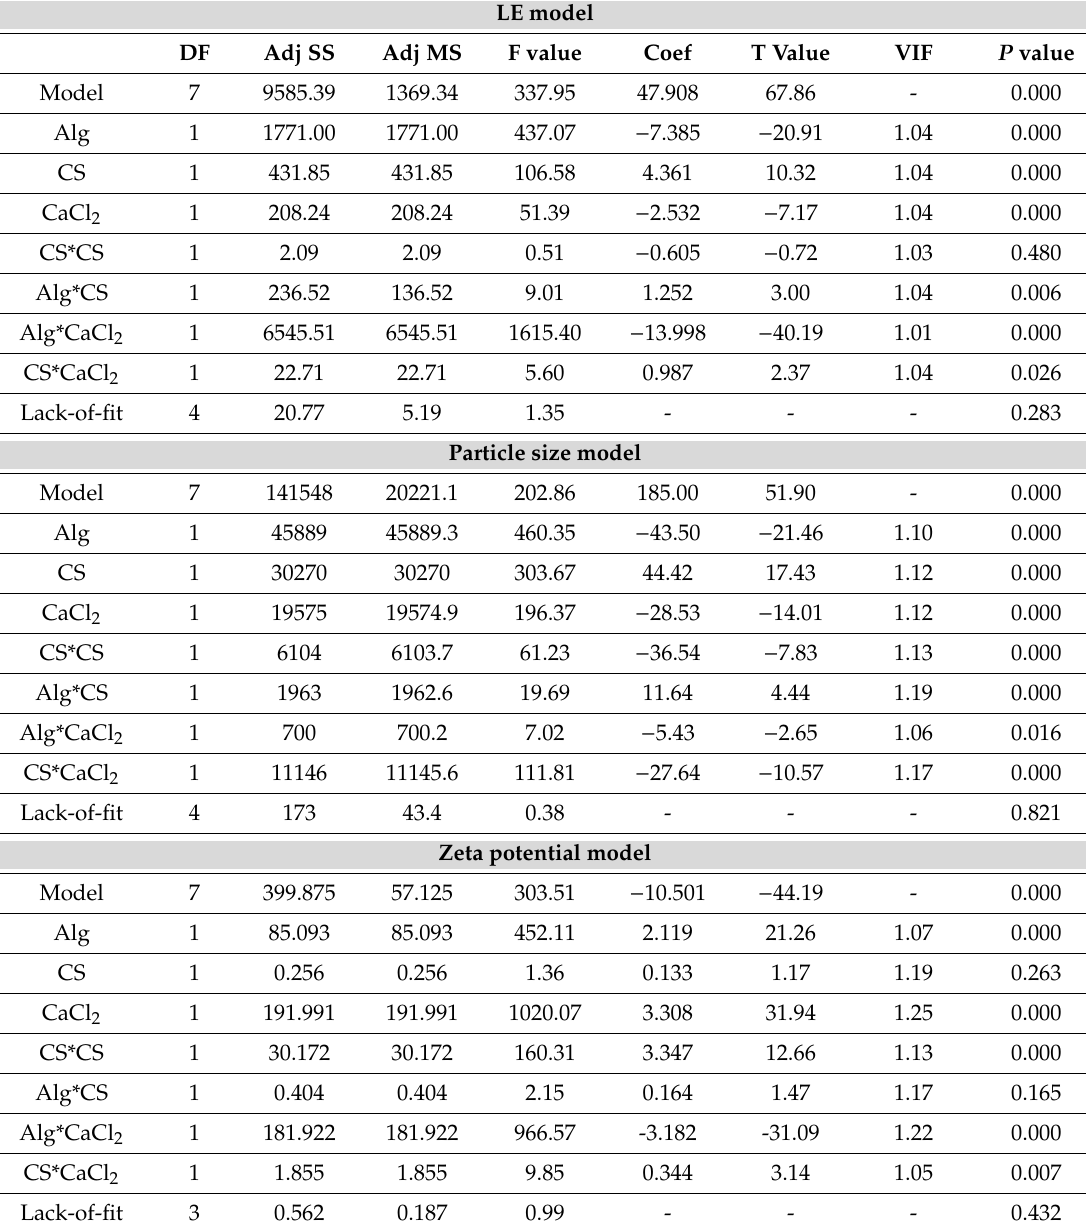
Table 3. ANOVA values for loading e ffi ciency (LE), particle size and zeta